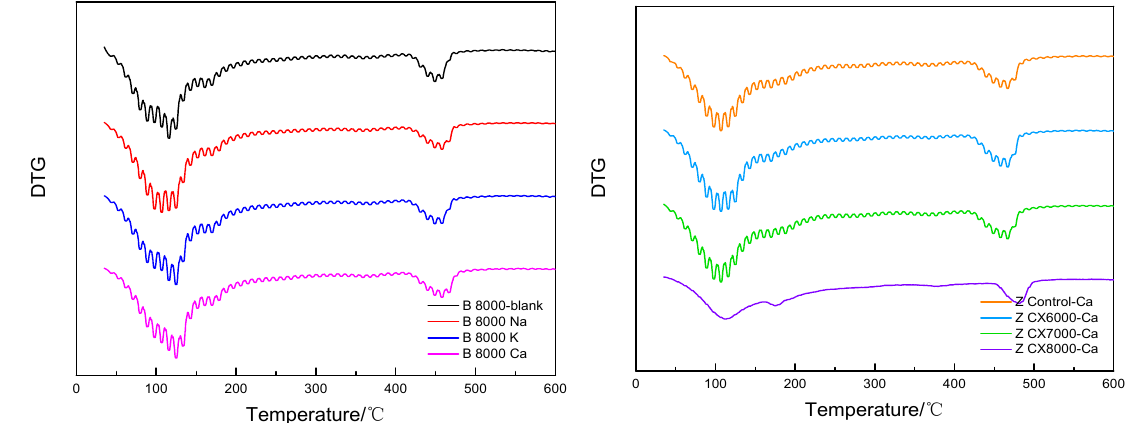
( f ) 90 d DTG curves of ultrafine cement with different curing temperatures. Figure 5. TG/DTG curves of ultrafine cement system at different Figure 5. TG/DTG curves of ultrafine cement system at different ages. By comparing the TGA curves of three ages, it was found that with the increase of age, the influence of different hardening accelerators on ultrafine cement became smaller and smaller. The early TG curves showed that the group added with Na 3 SiO 3 had the least amount of mass loss and the lowest degree of hydration, but it was found that in the latter, there was no significant difference among the samples with different types of hardening